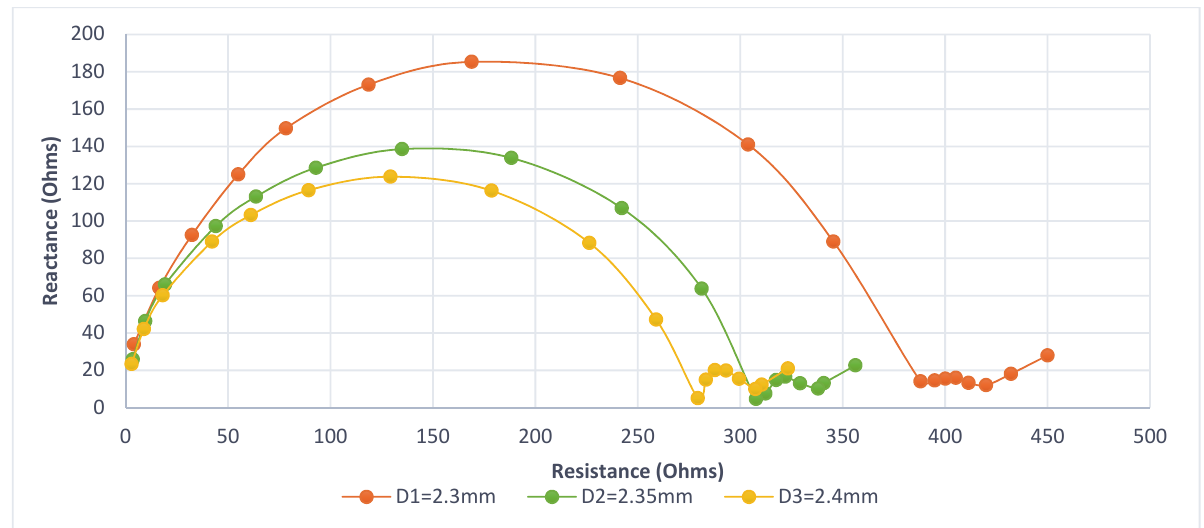
Fig.5: Cole plot of obtained Resistance vs Reactance for three arterial